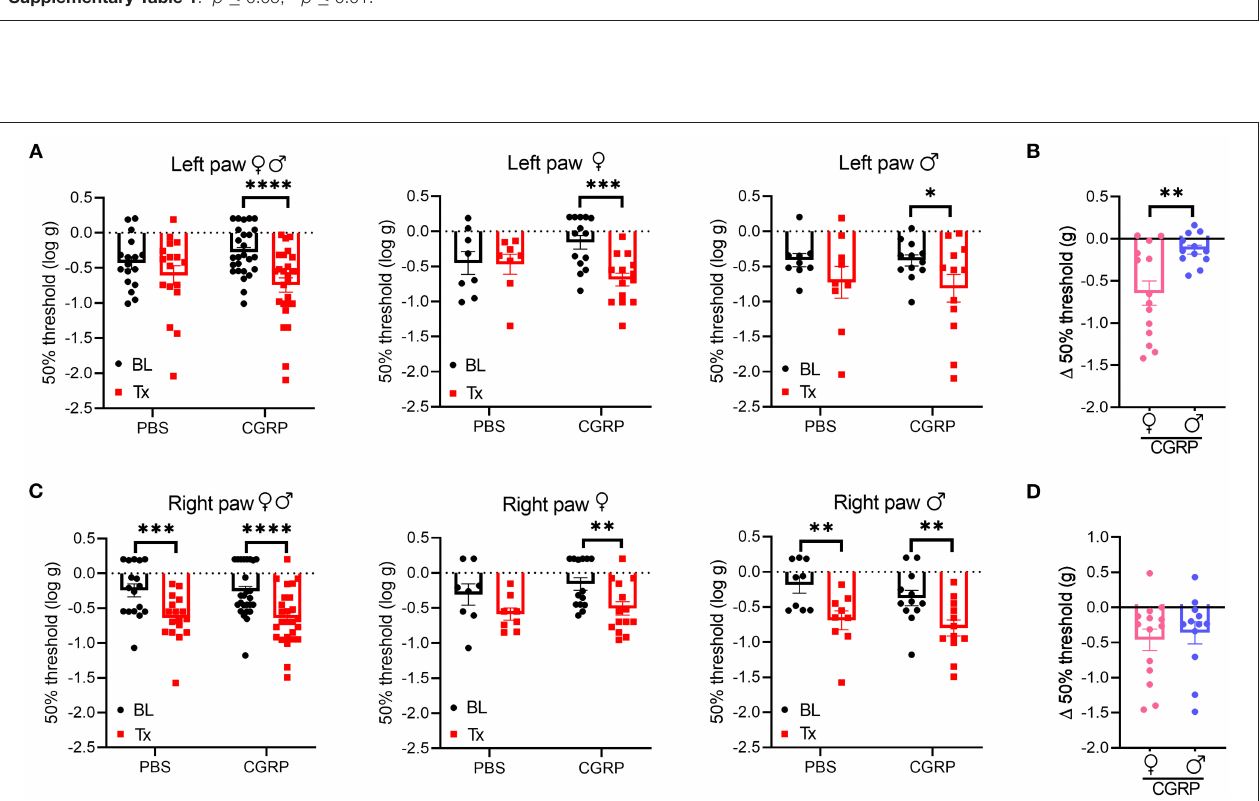
FIGURE 5 | Injection of CGRP into the MN induced plantar tactile hypersensitivity in the contralateral hind paw. Plantar tactile sensitivity was assessed with injection of PBS or CGRP (1 µ g/200 nl) into the right MN of C57BL/6J mice via cannulas. Data are from three independent experiments. (A) The individual thresholds of left hind paws for all mice (left) (PBS: n = 17; CGRP: n = 26), female mice (middle) (PBS: n = 8; CGRP: n = 14), and male mice (right) (PBS: n = 9; CGRP: n = 12). (B) Comparison of changes in withdrawal thresholds of left hind paws between CGRP-treated female and CGRP-treated male mice. The change in thresholds was measured by subtracting respective baseline from CGRP treatment measurements. (C) The individual thresholds of right hind paws for all mice (left) (PBS: n = 17; CGRP: n = 26), female mice (middle) (PBS: n = 8; CGRP: n = 14), and male mice (right) (PBS: n = 9; CGRP: n = 12). (D) Comparison of changes in withdrawal thresholds of right hind paws between CGRP-treated female and CGRP-treated male mice. The mean ± SEM 50% thresholds are presented. Statistics are described in Supplementary Table 1 . * p ≤ 0.05, ** p ≤ 0.01, *** p ≤ 0.001, **** p ≤ 0.0001.